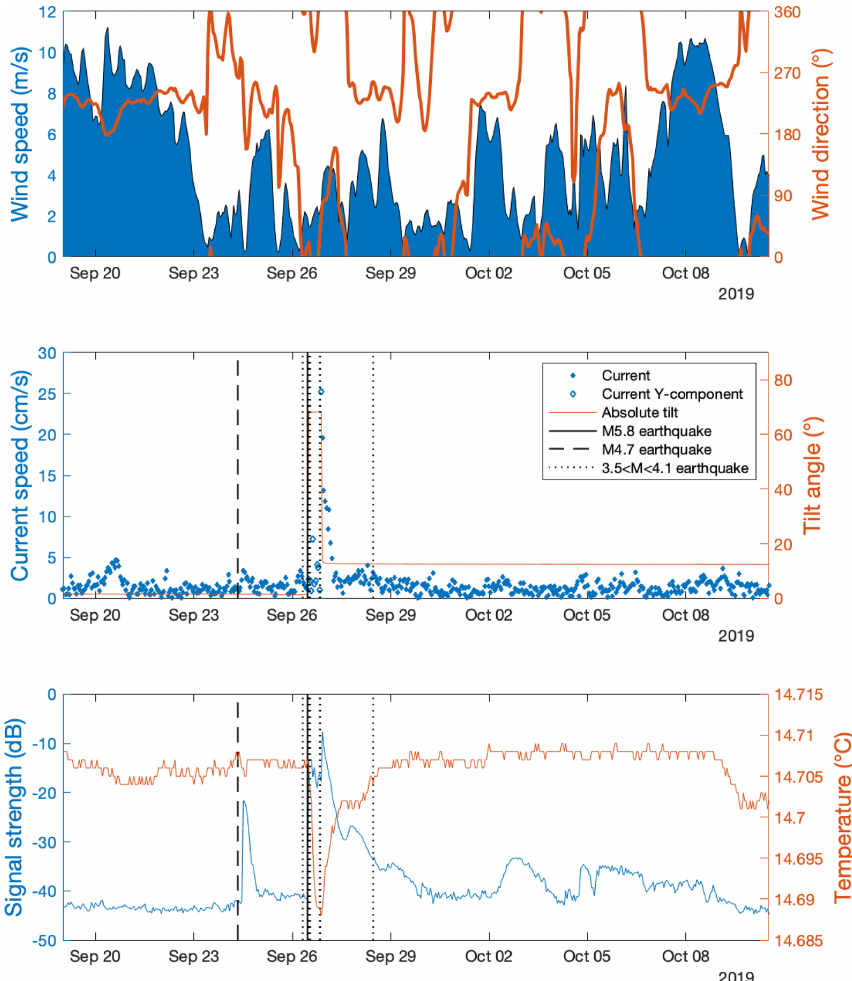
Figure 5. Time series acquired with a SeaGuard RCM during the September 2019 seismicity cluster and ERA5 reanalyzed meteorolog- ical data (Hersbach et al., 2018): ERA5 wind data (top panel), current speed and tilt (middle panel), and backscatter signal strength and temperature (bottom